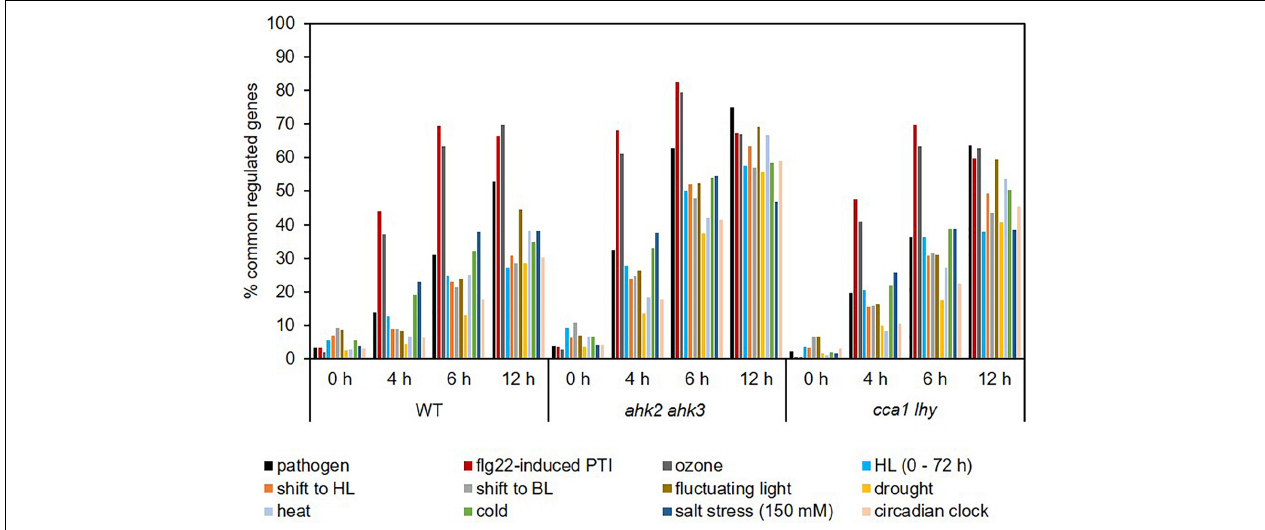
FIGURE 5 | Photoperiod stress transcript profiles are similar to transcript profiles in response to pathogen and ozone stress. Percentage of genes commonly regulated in response to photoperiod stress and various abiotic and biotic stresses. An overview of the responses of the transcripts altered by these different stresses to photoperiod stress is provided in Supplementary Data 7 . HL, high light; BL, blue